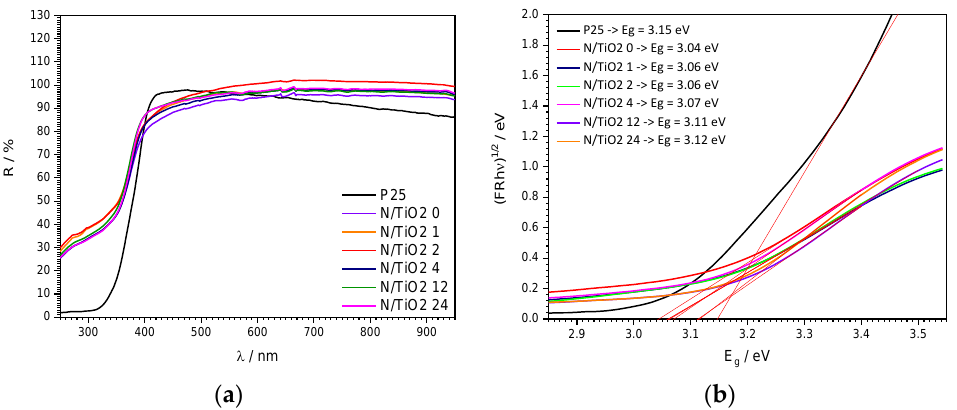
Figure 7. ( a ) DRS spectra and ( b ) Tauc plot for energy bandgap determination of N/TiO 2 materials and Degussa P25.